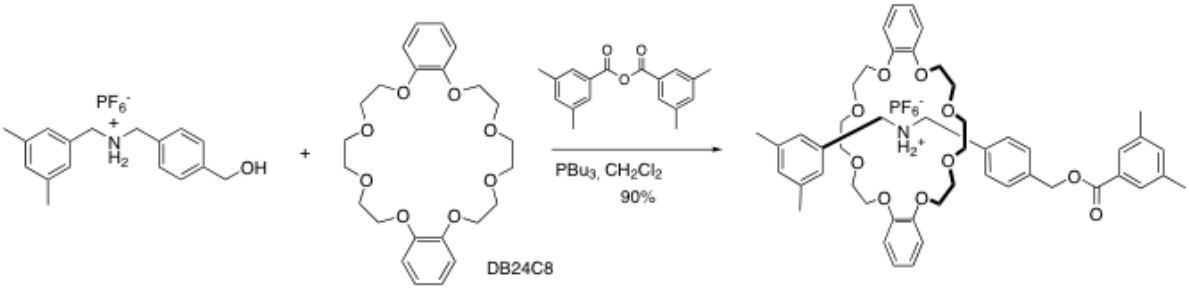
Scheme 1. Formation of a rotaxane by an esterification